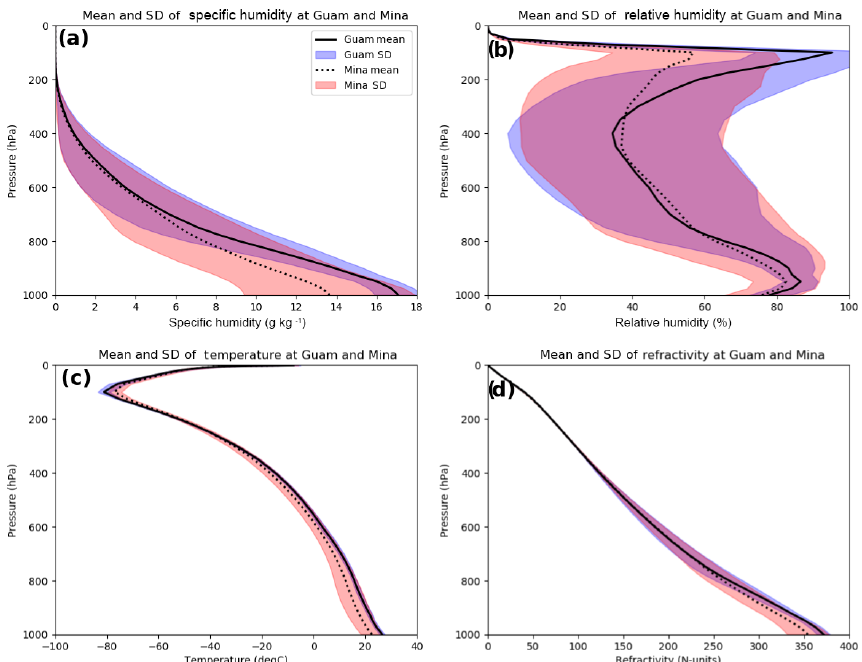
Figure 2. The mean ERA profiles over 2007 at Guam and Mina of specific humidity q (a) , relative humidity RH (b) , temperature T (c) , and refractivity N (d) . The standard deviations about the mean profiles are indicated by the